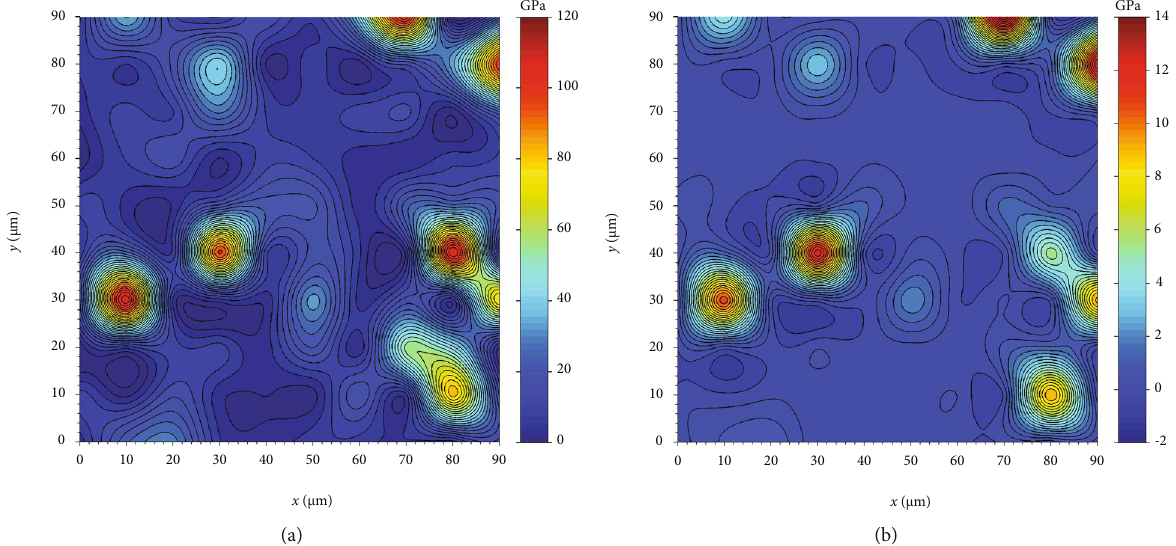
Figure 11: Distribution of (a) indentation modulus and (b) hardness in the tested region of specimen NM-3.